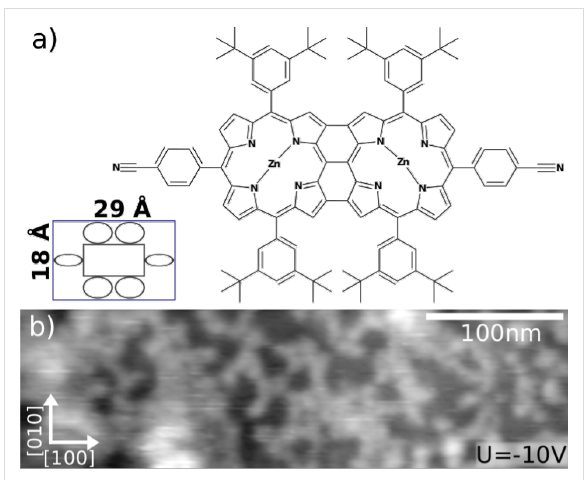
Figure 3: a) Chemical structure of the used triply fused diporphyrin molecule derivative prepared according to the synthetic protocols by D. Bonifazi et al. [39]. The inset shows a molecular scheme and the dimensions. b) Topography image after the UHV-ESI deposition of the porphyrins on KBr(001) for 5 min. Scan parameter: A = 2 nm, Δ f = − 25 Hz, U = − 10